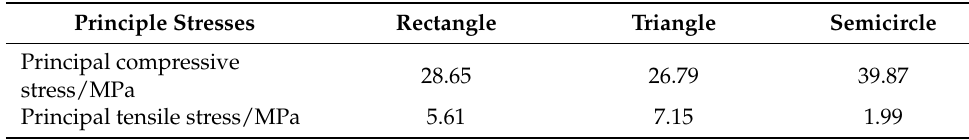
Table 1. The maximum principal stresses in the